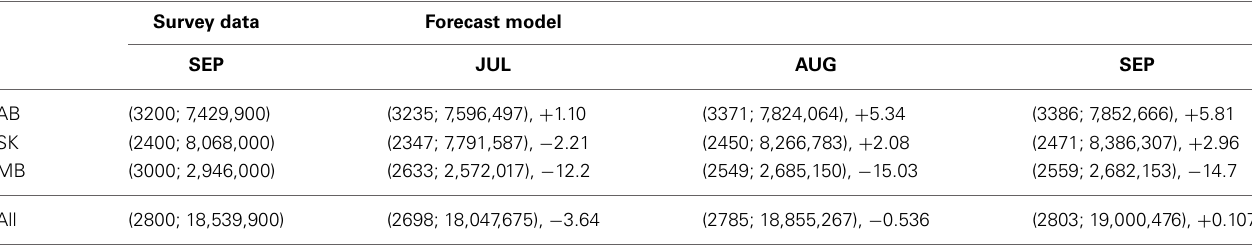
Table 4 | Comparison of model forecasts (using both agro-climate and NDVI indices) to Statistics Canada field crop-reporting survey data (CCAP), upscaled to the provincial scale.